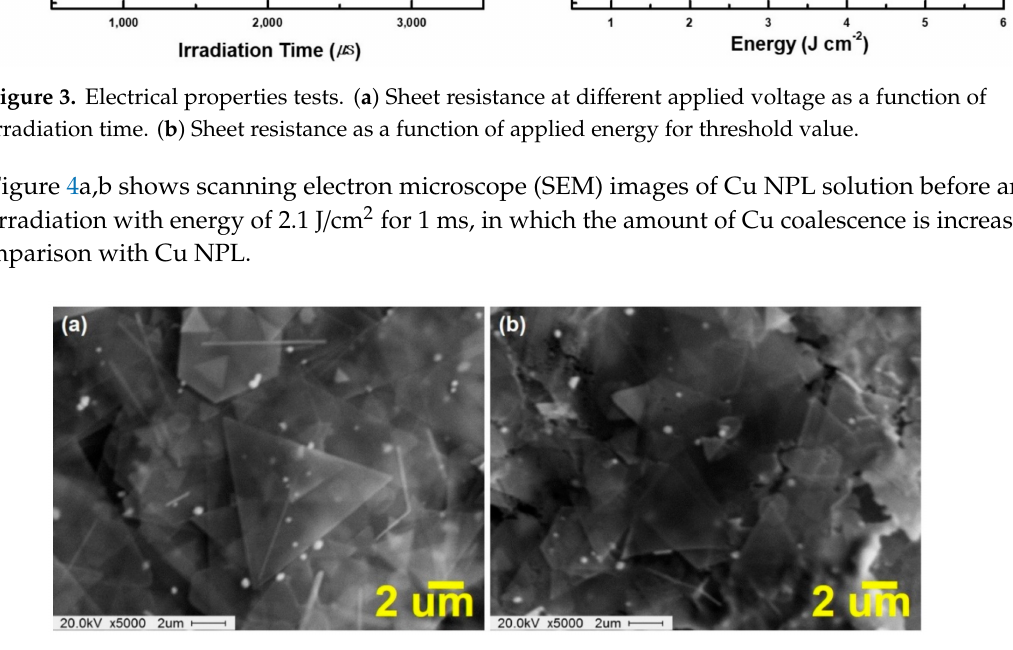
Figure 4. Scanning electron microscopy images. ( a ) Cu NPL image before irradiation. ( b ) Cu NPL image after irradiation